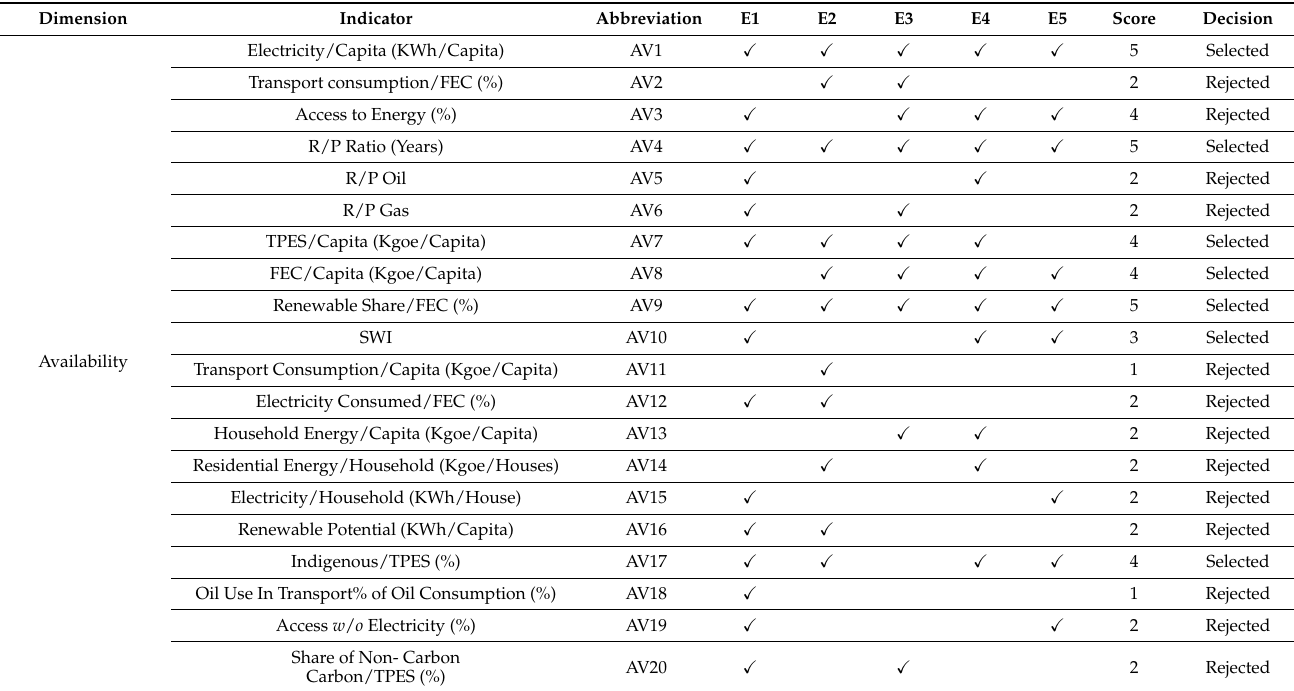
Figure 1. Framework for indicator and indices development. Table 2. Reliability test results. Source: (Author’s own). Table 1. List of proposed indicators and expert selection. Source: